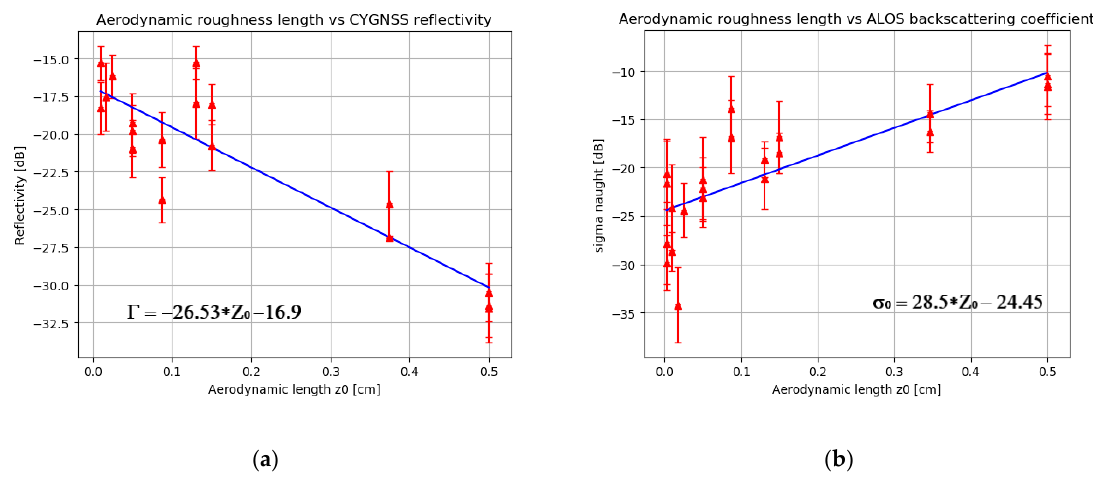
Figure 8. Plot of the aerodynamic roughness length as a function of satellite data: ( a ) CYGNSS reflectivity, ( b ) ALOS-2 backscattering coefficient.